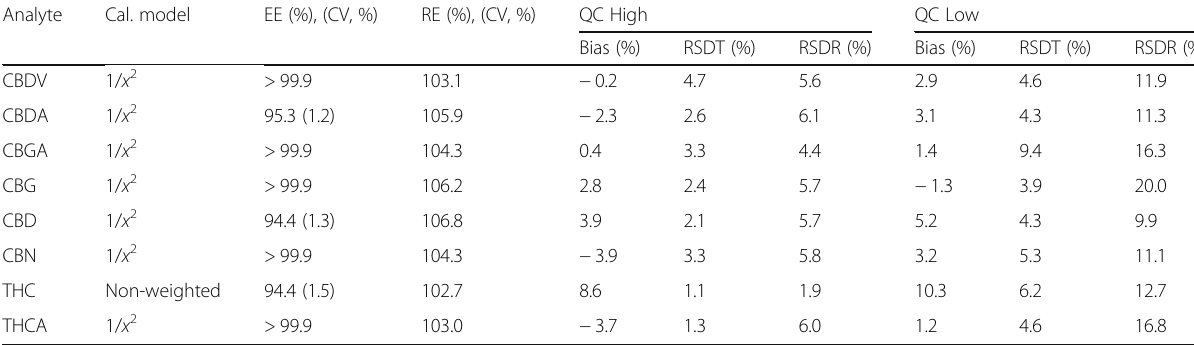
Table 2 Method validation data: recovery effect, bias, intra-day precision (RSD R ), interday-precision (RSD T ) Analyte Cal.